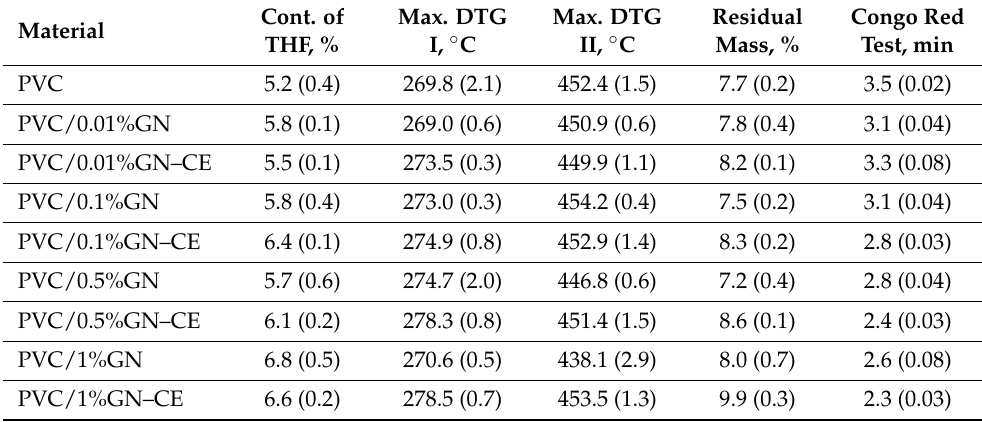
Table 2. Thermal properties of PVC/GN and PVC/GN–CE nanocomposites.